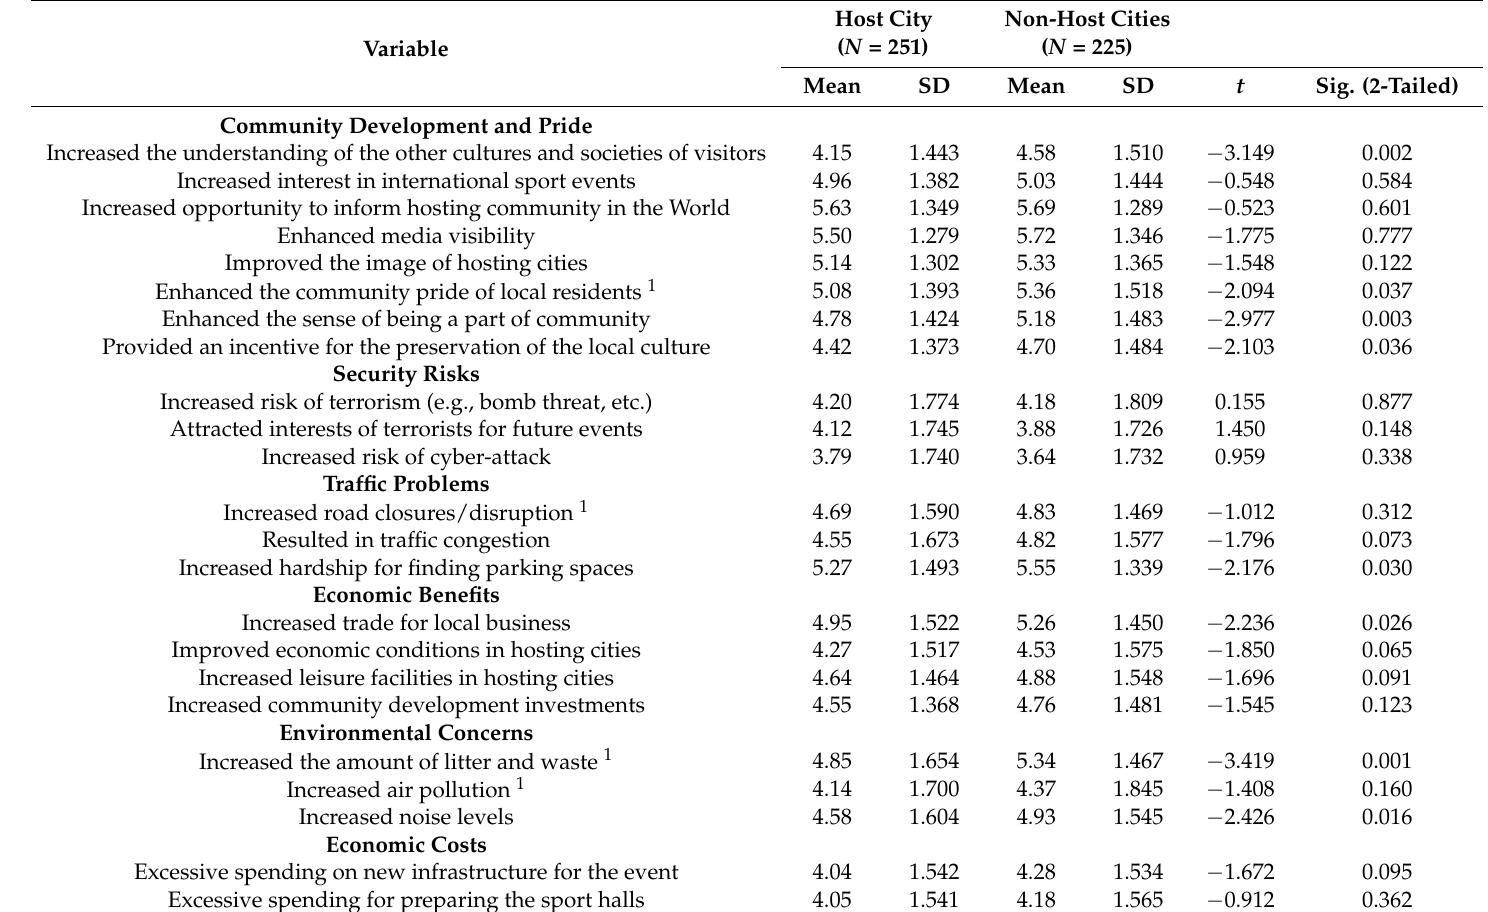
Table 4. Results of the t